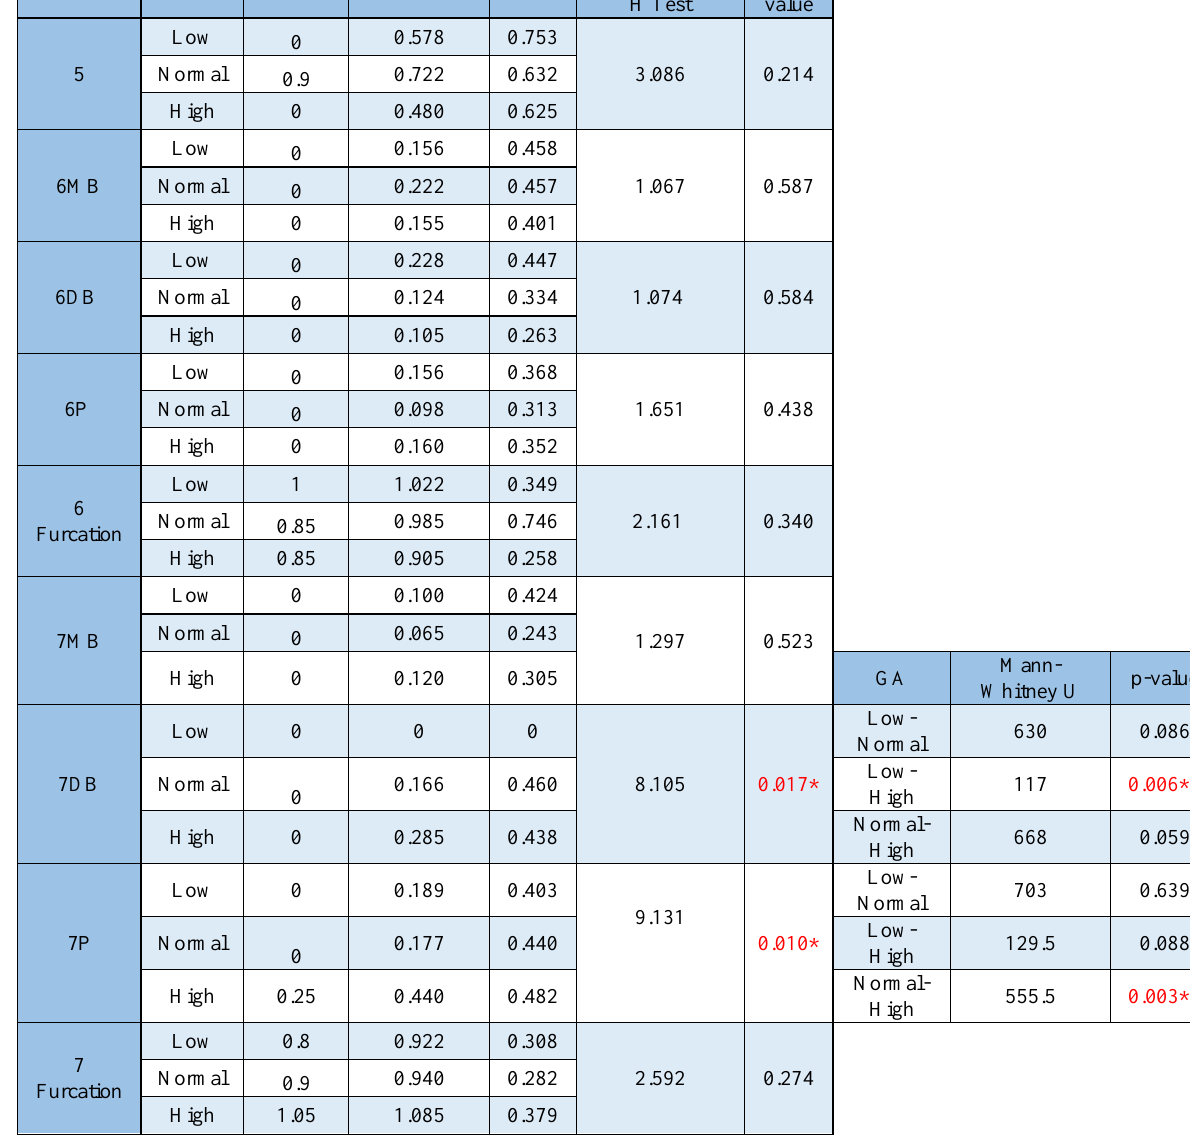
Table 5: Thickness of the sinus floor above root on CBCT according to gonial angle